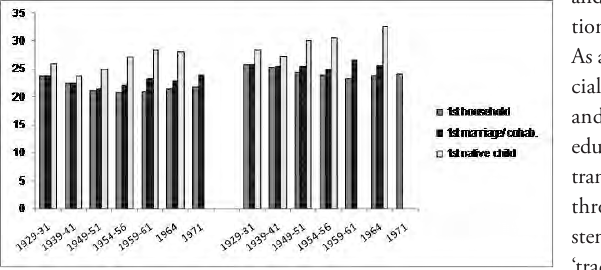
Figure 3: Median ages (years) of important life events, by birth cohort Women (left) – Men